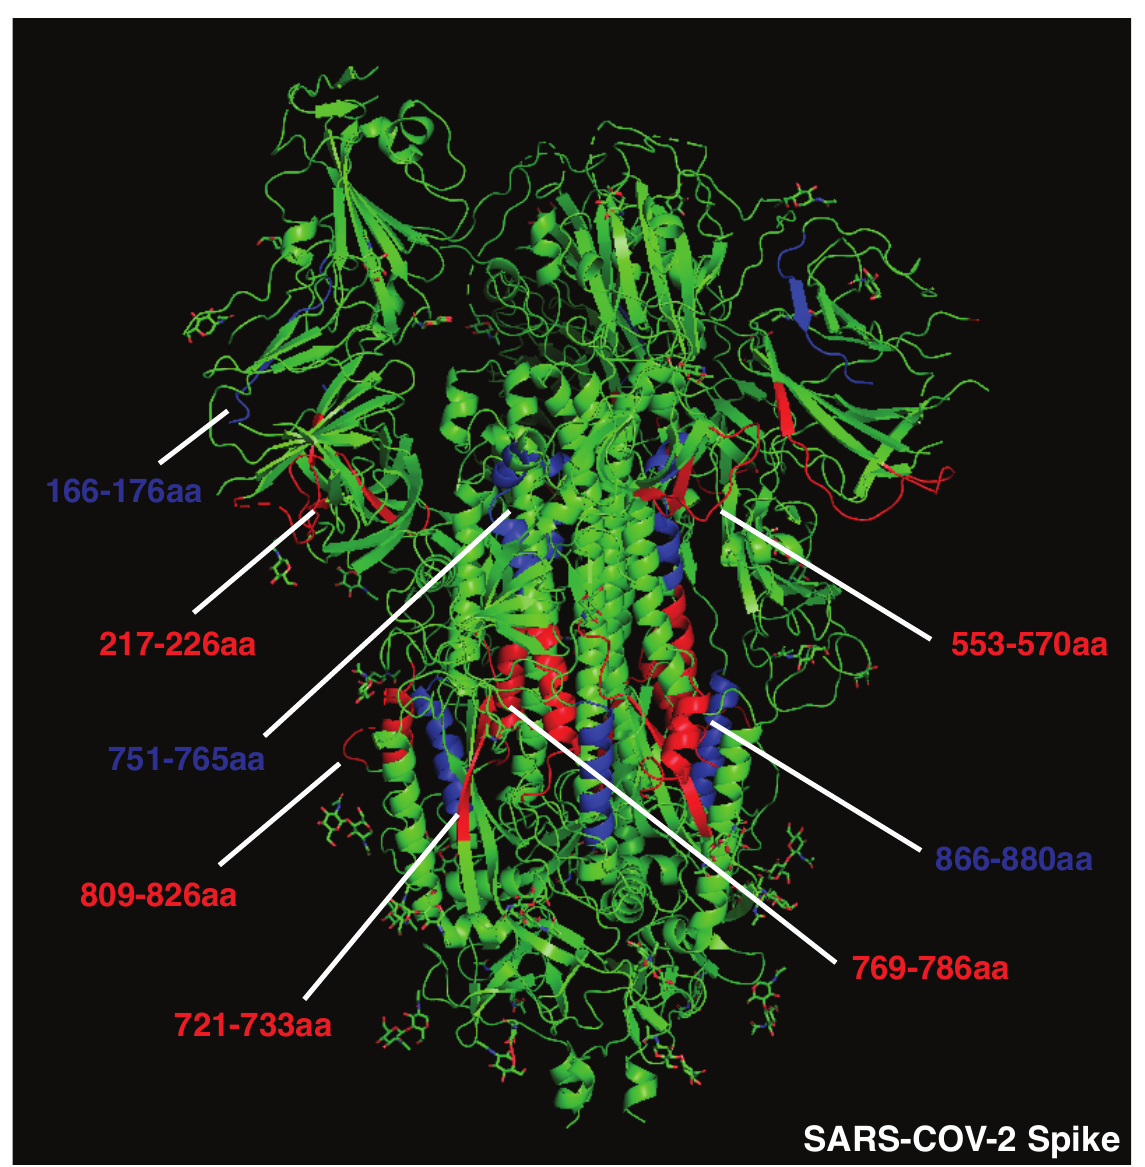
Figure 2. Crystal structure of SARS-CoV-2 spike protein (PDB:6VSB). Immunodominant B cell epitopes are depicted in red, while dominant CD4 determinants are highlighted in